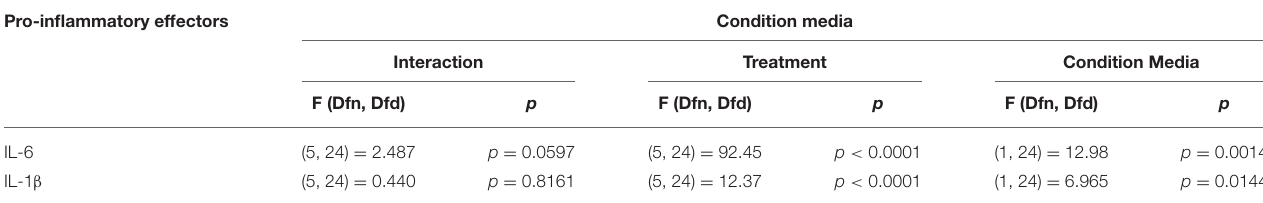
TABLE 3 | Conditioned media-mediated cytokine profile of BM and SCM. Pro-inflammatory